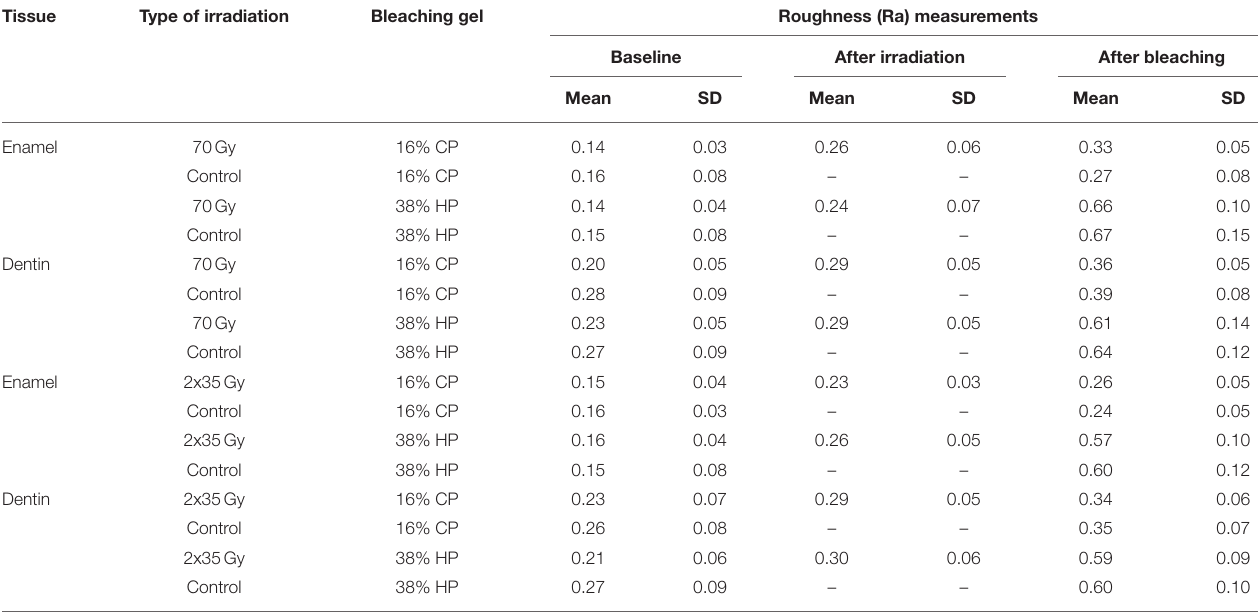
TABLE 3 | Summary of baseline, irradiation, and bleaching measurements of enamel and dentin roughness across different treatment groups.